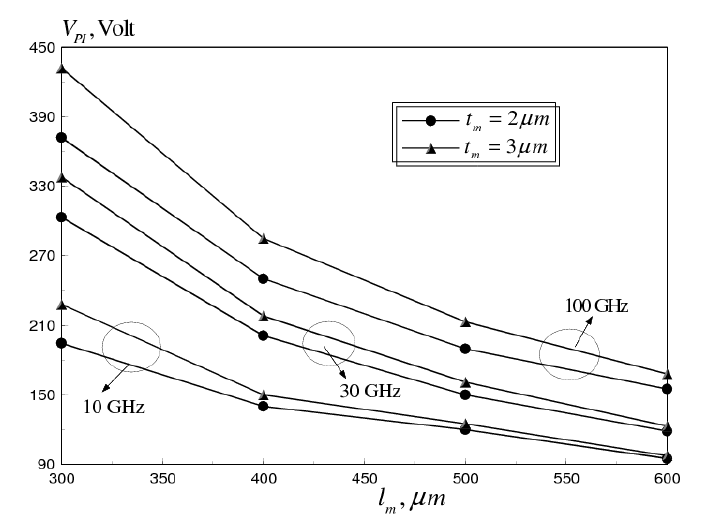
= 20 µm , t = 2 and 3 µm m m